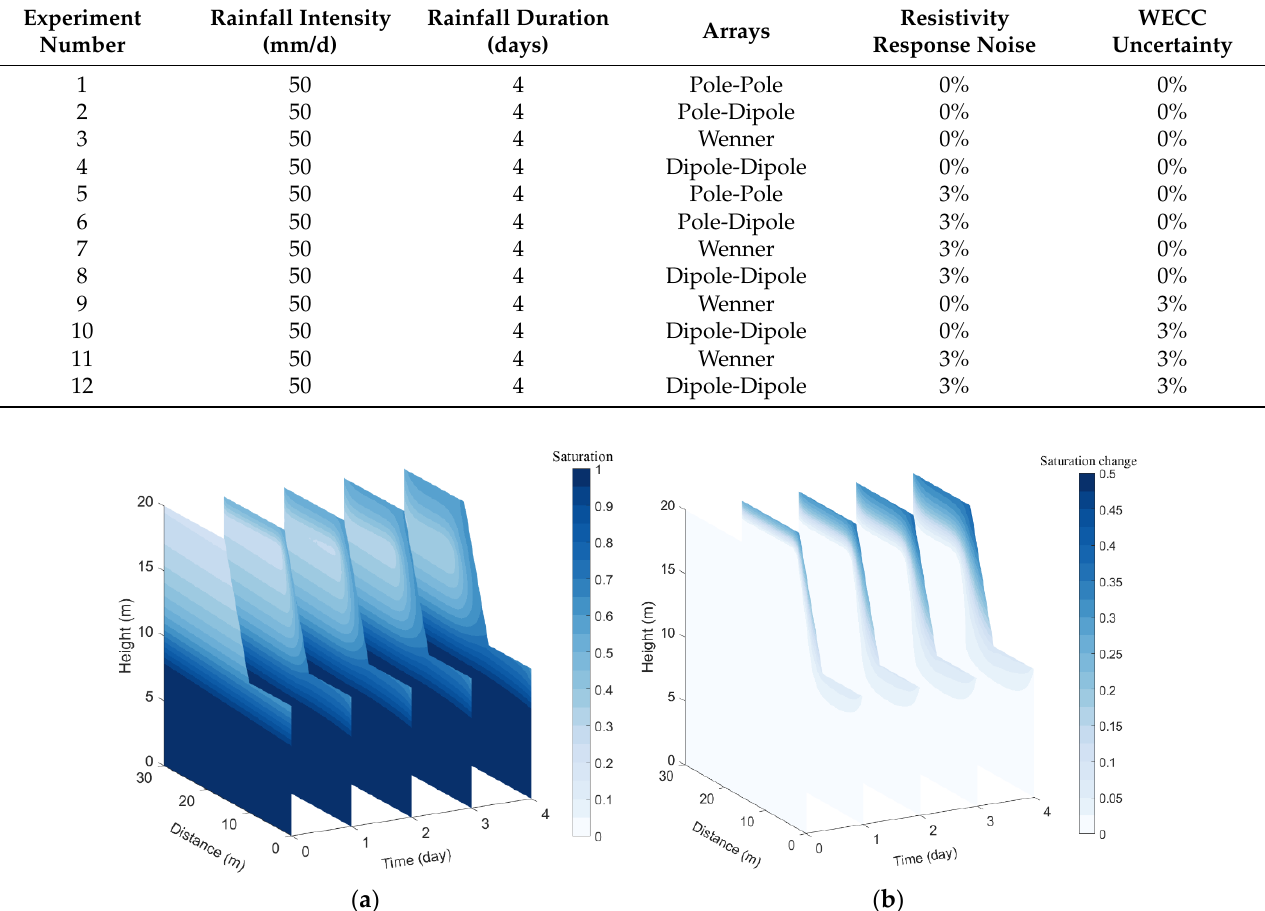
Figure 3. Saturation distribution and saturation variation from numerical simulation: ( a ) Saturation distribution; ( b ) Saturation variation.